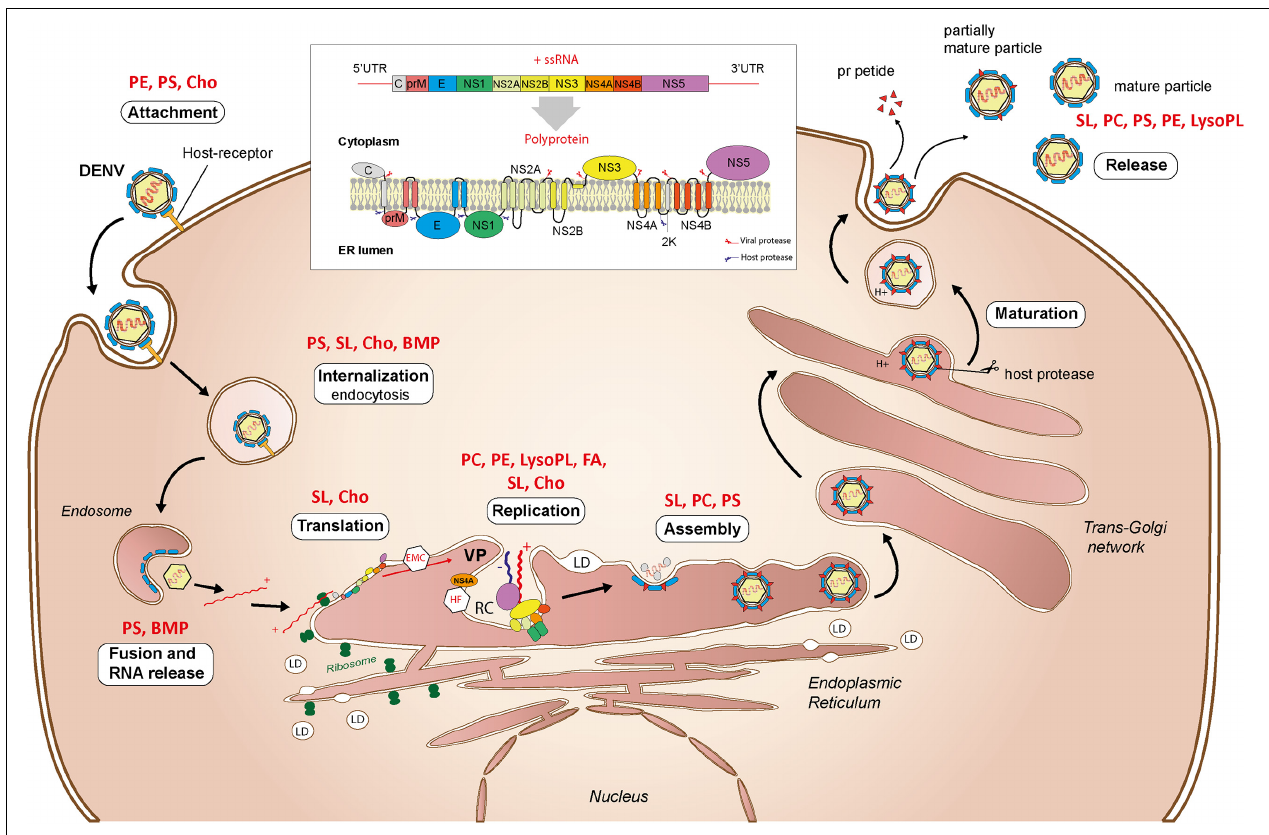
FIGURE 7 | Interactions with lipids during the flavivirus cellular cycle. Attachment, internalization, translation, replication, assembly, maturation, and virus particle release are depicted. Structural lipids involved in the different stages as determined in uninfected cells are indicated in red. UTR, untranslated transcribed region; VP, vesicle packets; RC, replication complex; LD, lipid droplet, ER, endoplasmic reticulum; PE, phosphatidylethanolamine; PS, phosphatidylserine; PC, phosphatidylcholine; SL, sphingolipid; LysoPL, lysophospholipid; Cho, cholesterol; BMP, bis(monoacylglycero)phosphate; FA, fatty